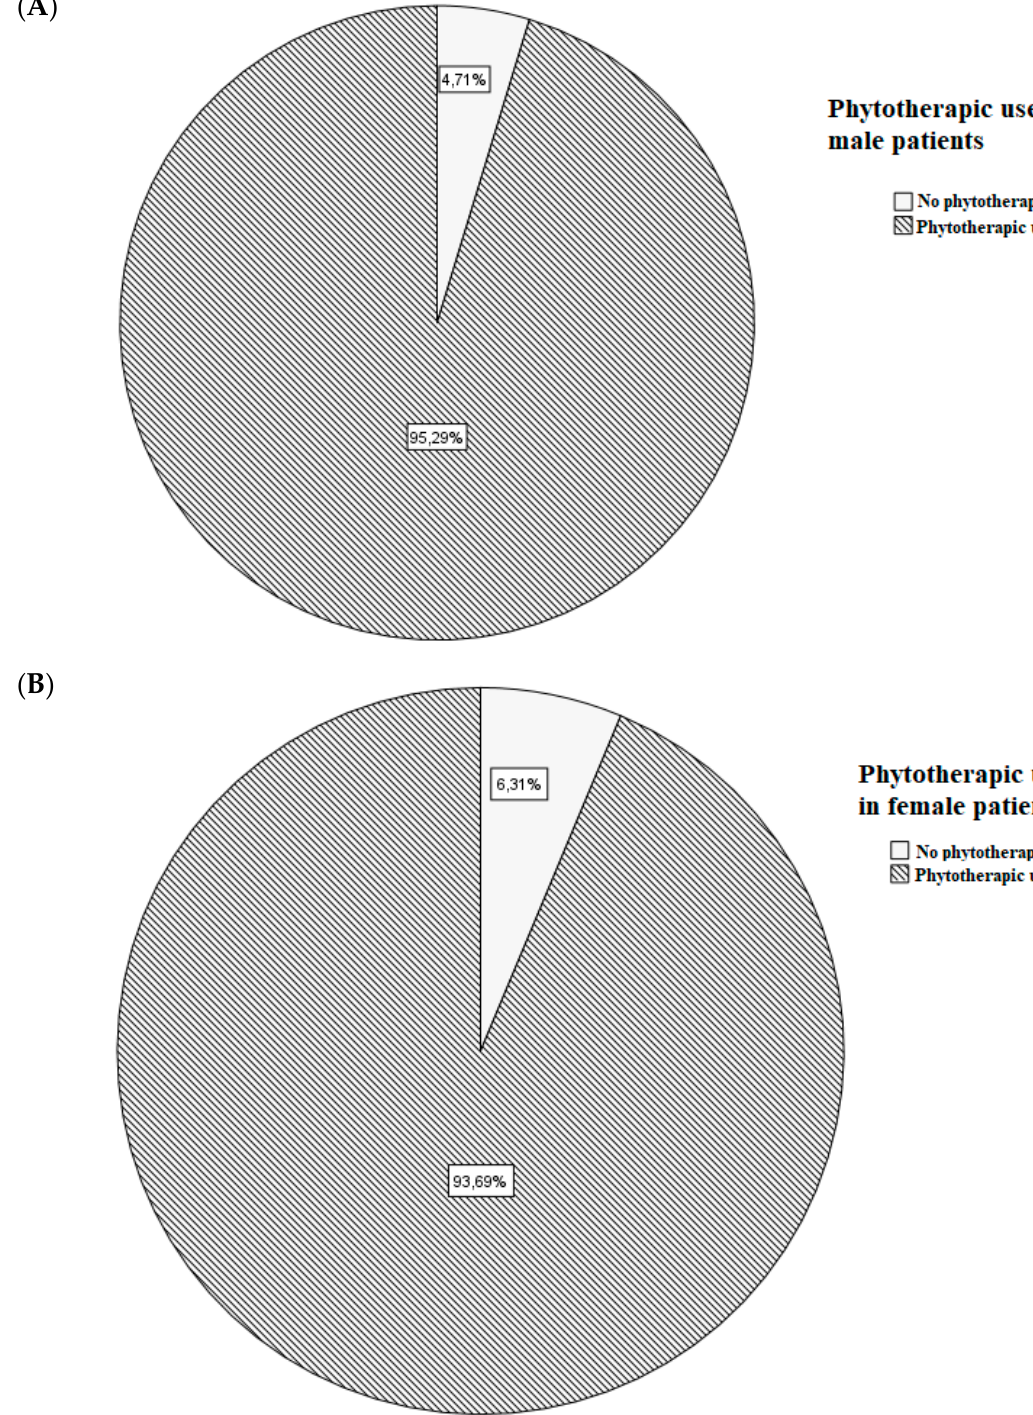
Figure 1. Frequency of phytotherapic use in male ( A ) and female ( B ) patients.